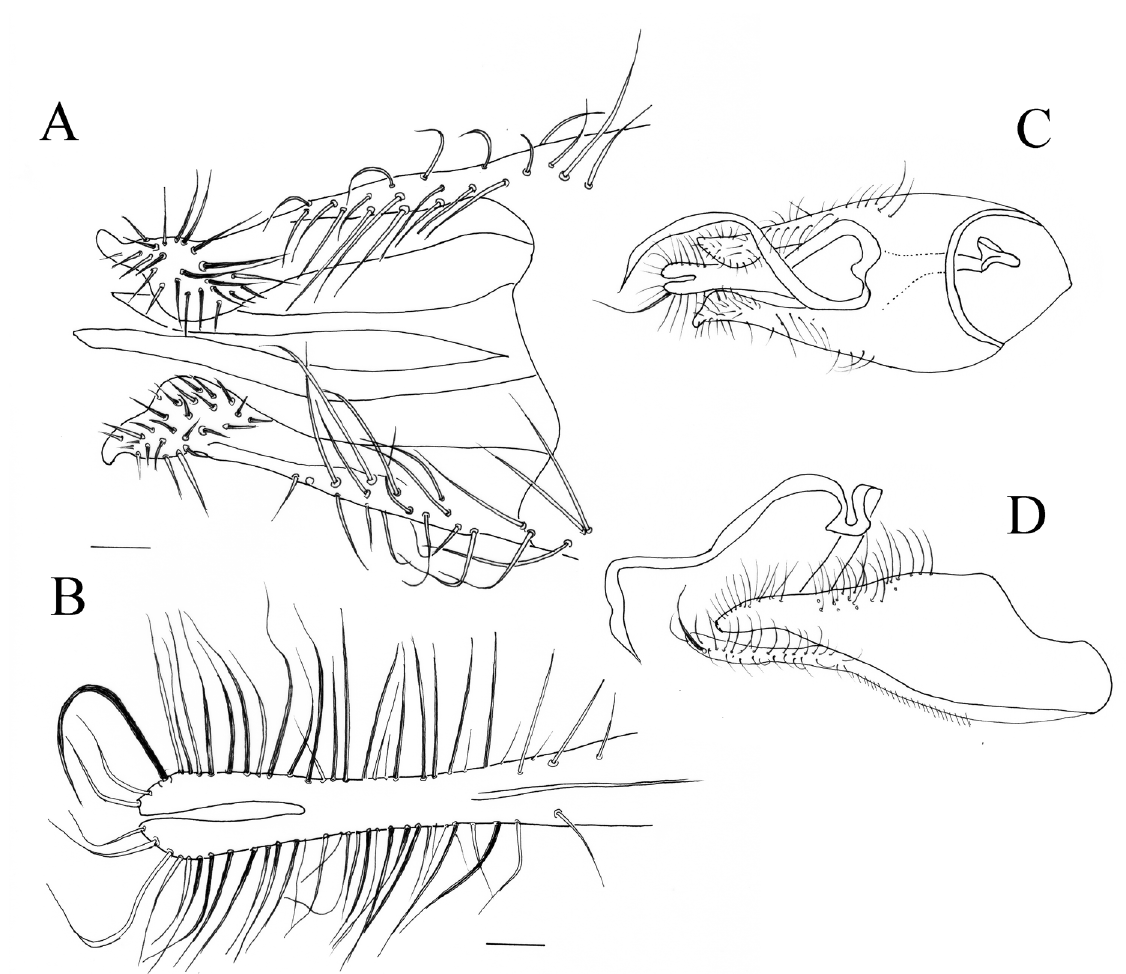
Fig. 7. Thinophilus plektron Samoh & Grootaert sp. nov. Male terminalia (Abdulloh Samoh leg., PSUNHM (PSUZCDIP0013)). A . Ventral view of tips of surtstyli. B . Dorsal view of tip of fused cerci. C . Ventral view of epandrium. D . Lateral view on epandrium. Scale = 1